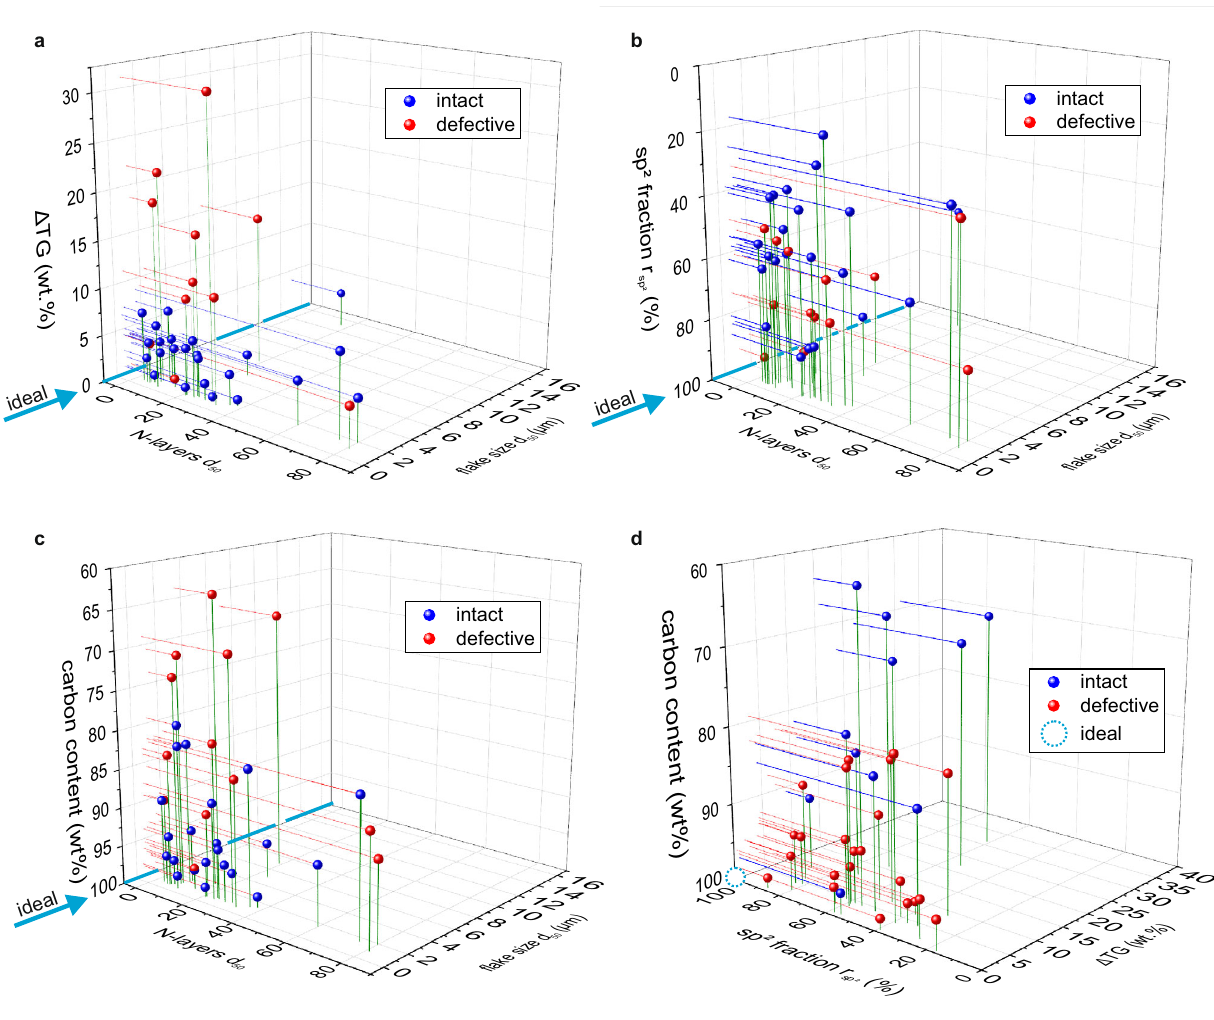
Fig. 2 Characterization of nominal graphene materials (NGM). Three-dimensional plots of the physiochemical properties de fi ning the quality of graphene according to Wick et al., with a Δ TG. b r ( sp 2 ); and c wt %( C ). d 3-Dimensioal plot comparing all three before-named measures for the degree of functionalization. A blue bar or blue circle indicates the direction of “ ideal ” graphene: The more the points are located at this axis or point, respectively, the more ideal the structure 31